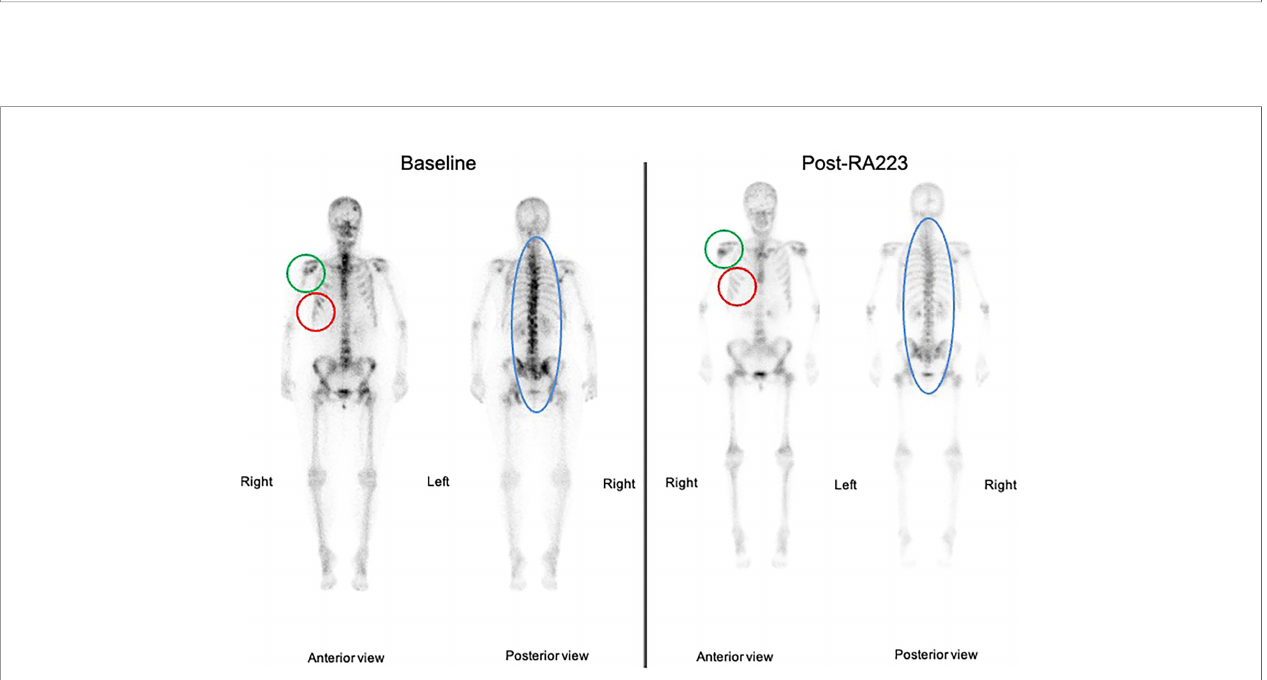
FIGURE 2 | 99 mTc-HDP bone scan before and after radium-223 treatment. The images circled in red depict a decrease of 99 Tc uptake re fl ecting decreased metastatic activity. The images circled in green show an increase in bone uptake in the right humeral head re fl ecting bone reconstruction (given a decrease of FDG uptake on PET-CT). The images circled in blue illustrate a global decrease in 99 Tc uptake of the axial